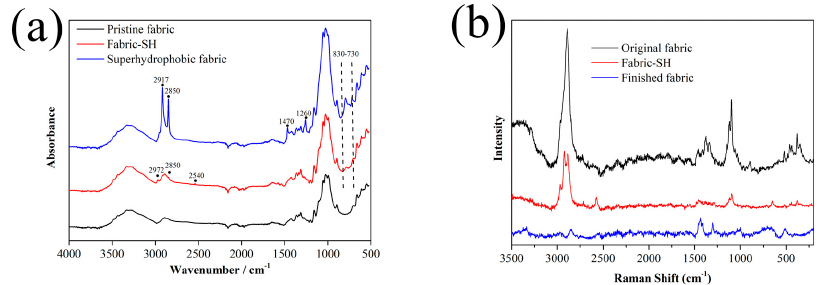
Figure 6. ( a ) FTIR-ATR and ( b ) Raman spectra of the original fabric, mercapto-modified fabric (fabric-SH) and finished fabric.